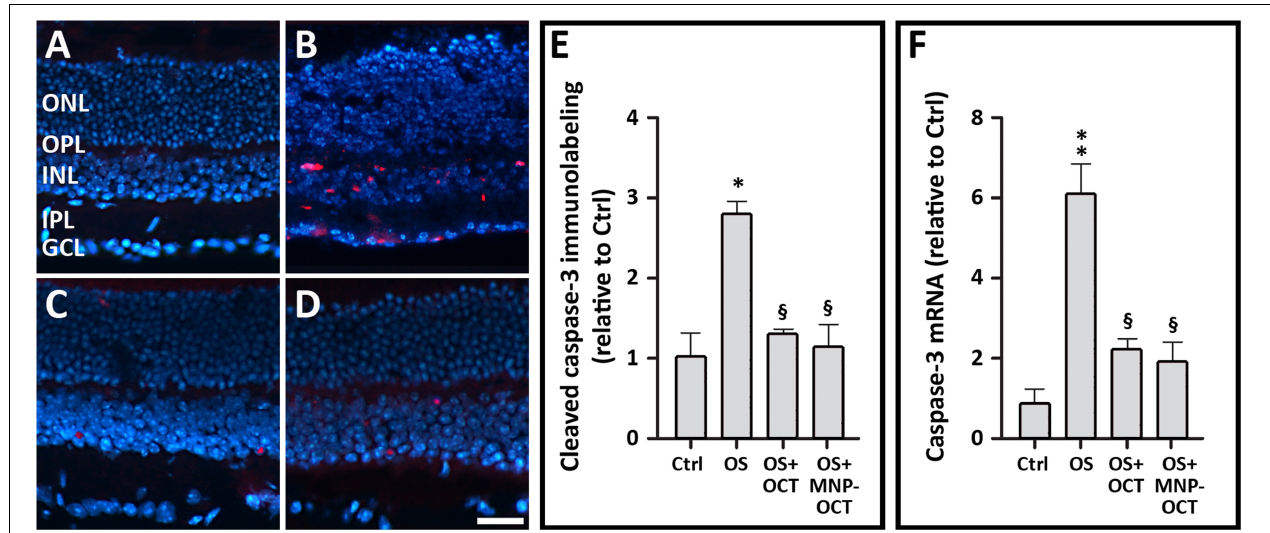
FIGURE 4 | Representative immunofluorescence images of cleaved caspase-3 in sections of retinal explants cultured in control conditions (A) , in OS (B) , in OS with 1 µ M OCT (C) or in OS with 1 µ M MNP-OCT (D) . Retinal layers are visualized with DAPI counterstain. Scale bar, 50 µ m. (E) Quantitative analysis of the number of cleaved caspase-3 immunopositive cells per unit length of retinal section. (F) Quantitative analysis of caspase-3 mRNA expression as evaluated with qPCR. Values are indicated as mean ± SEM. ∗ p < 0.05 and ∗∗ p < 0.01 vs. the respective Ctrl; § p < 0.05 vs. the respective OS; n = 3 both in (E,F) . GCL, ganglion cell layer; INL, inner nuclear layer; IPL, inner plexiform layer; ONL, outer nuclear layer; OPL, outer plexiform